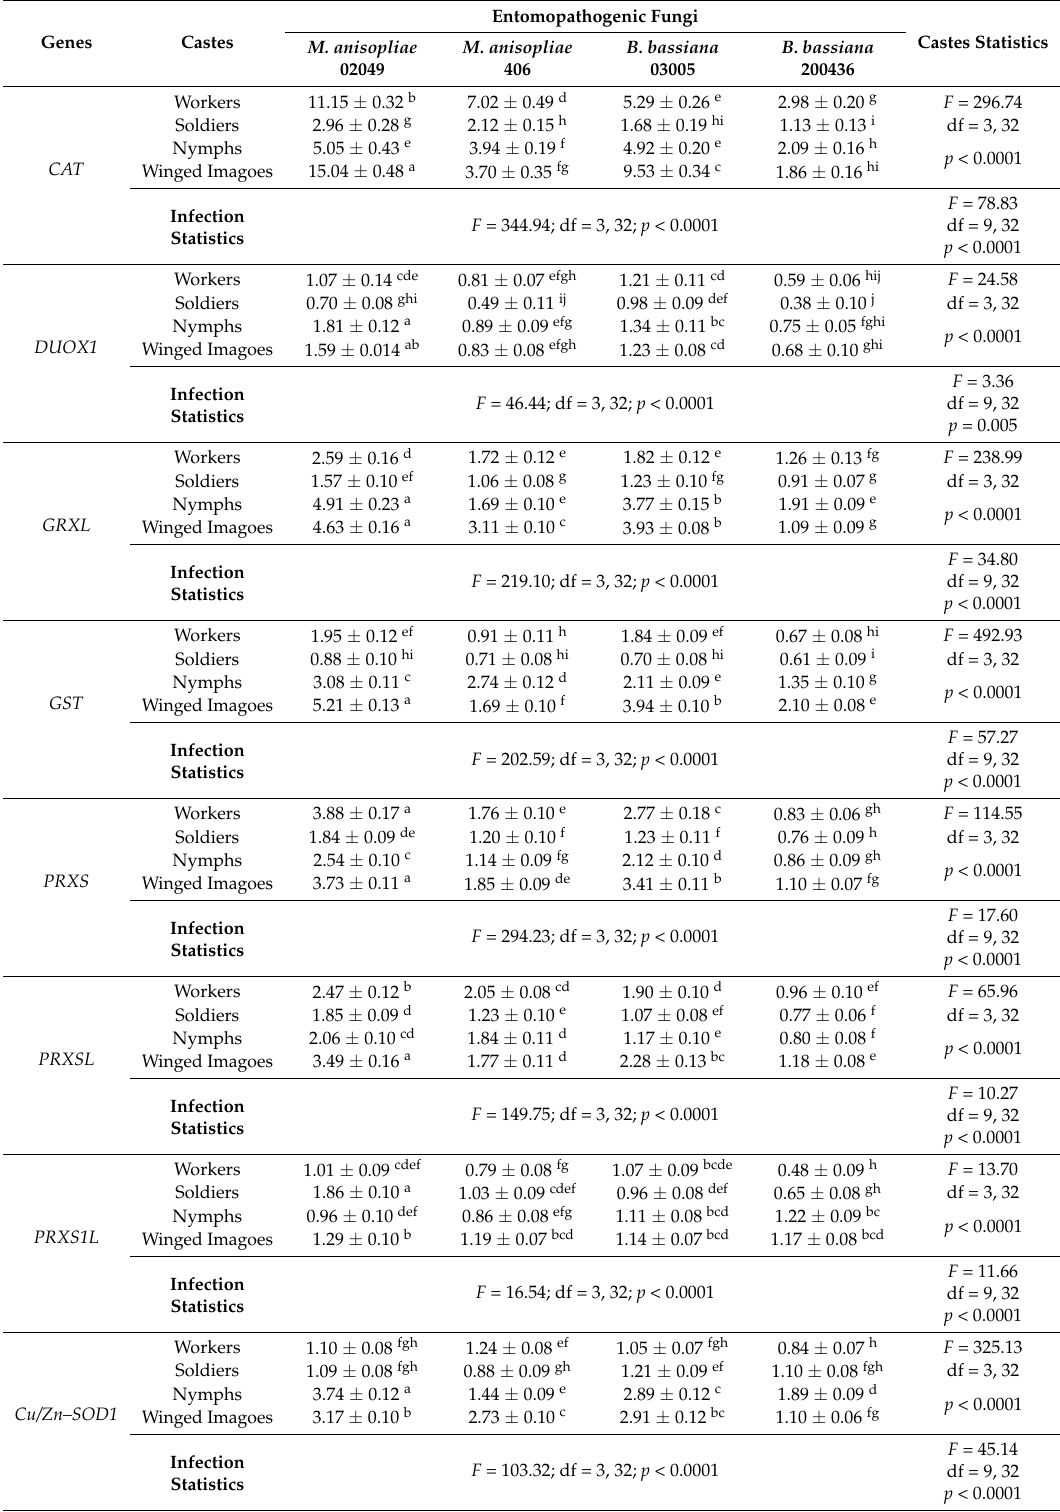
Table 3. Expression patterns of C. formosanus Shiraki antioxidant genes in the whole body homogenates of winged imagoes, nymphs, soldiers and workers using quantitative real-time PCR (qRT-PCR).